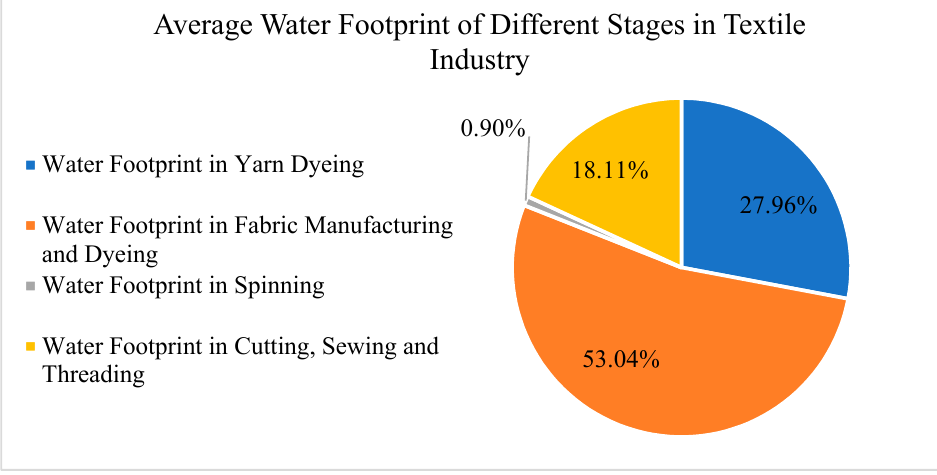
Figure 9. Percentage of water footprint in different stages in textile industry.